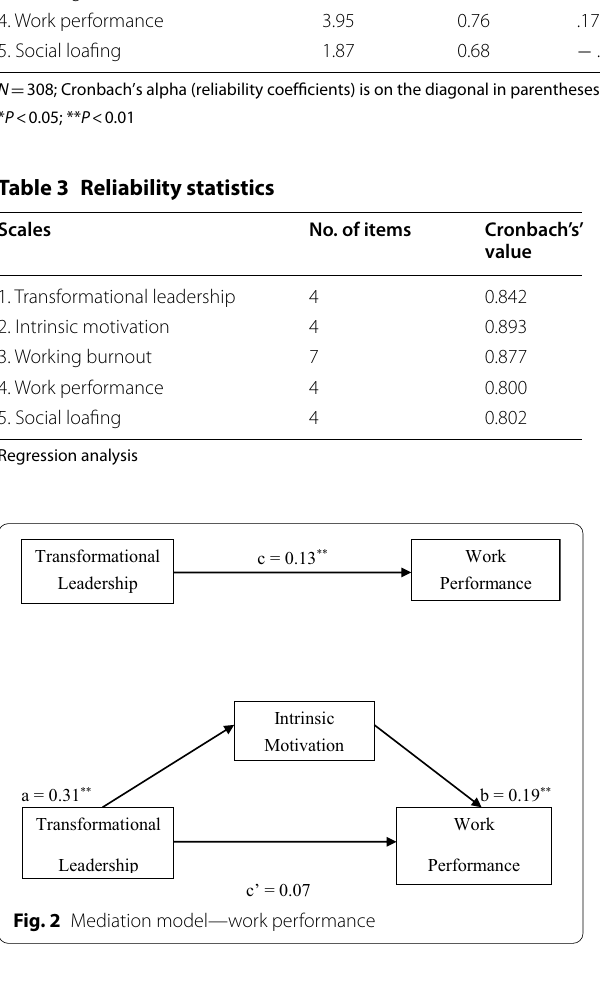
Table 6. According to the total effect model, the relation- ship between transformational leadership and social loaf- ing (path c , Fig. 4) is significant and negative ( β 0.32, = − t 9.57, p < 0.01) as shown in Table 6. = − The outcomes showed that intrinsic motivation and social loafing (path b , Fig. 4) are insignificantly and related relationship ( β 0.01, t 0.31, p > 0.01) which = − = − opposes Hypothesis 6. Our last finding determined that transformational leadership does not have a significant negative impact on social loafing (path c ′ , Fig. 3), while controlling intrin-